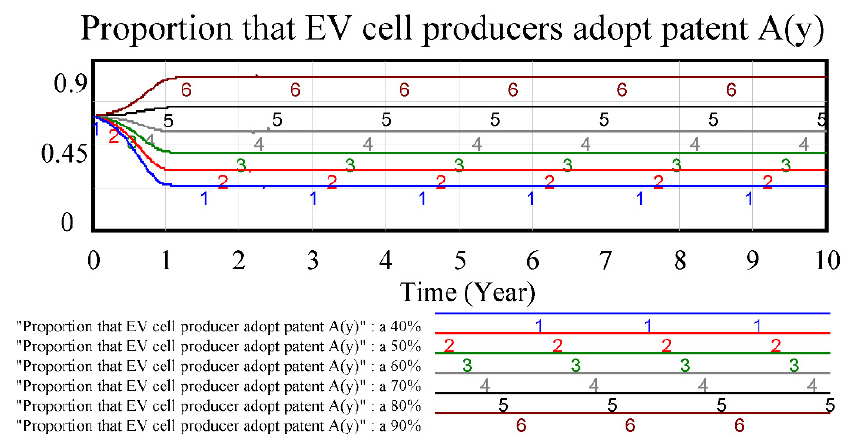
Figure 6. Sensitivity test of factor a that impacts EV cell producer.